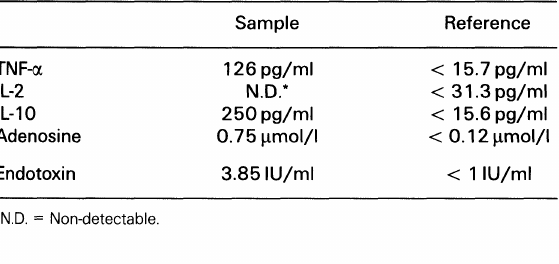
Table 1. Cytokine and adenosine levels in plasma